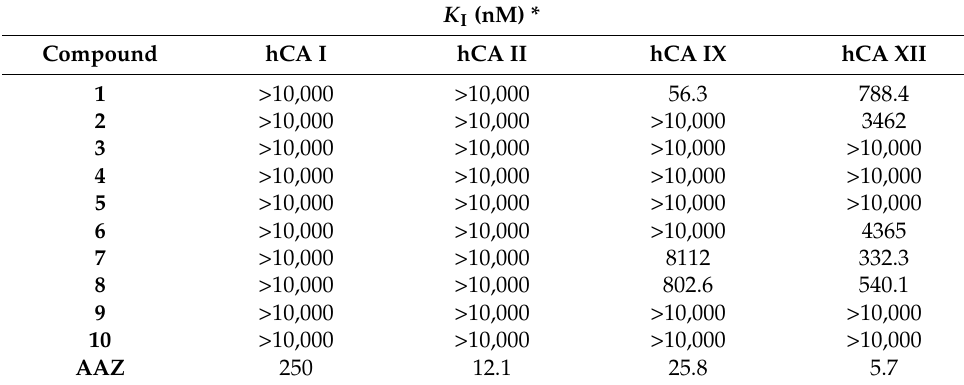
Table 1. Inhibition data against hCA I, hCA II, hCA IX, and hCA XII of compounds 1 – 10 , and